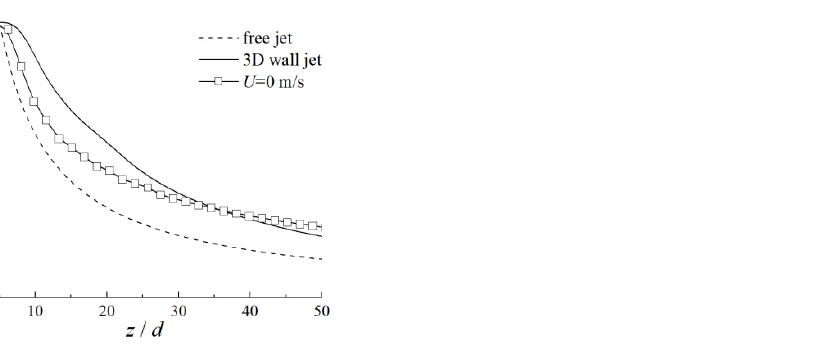
outlet by considering the ambient wind.